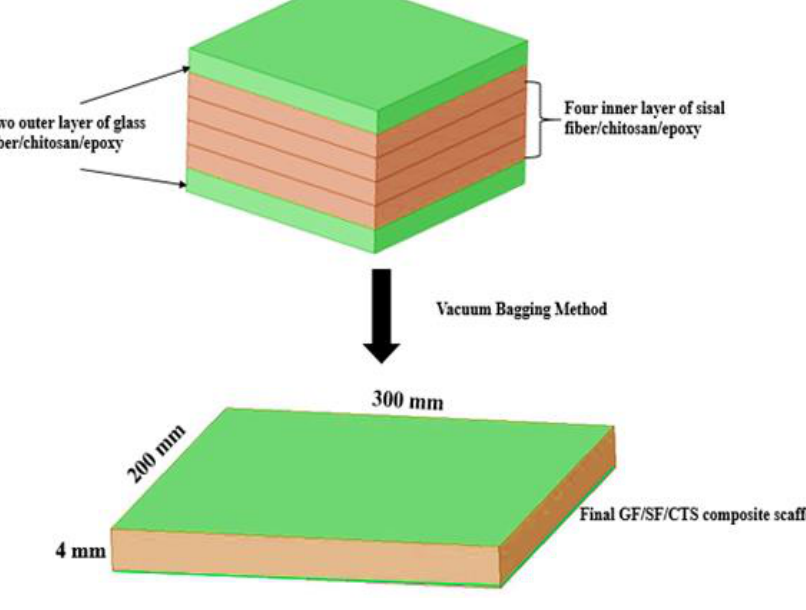
Figure 1. Sandwich structure of GF/SF/CTS composite scaffolds.